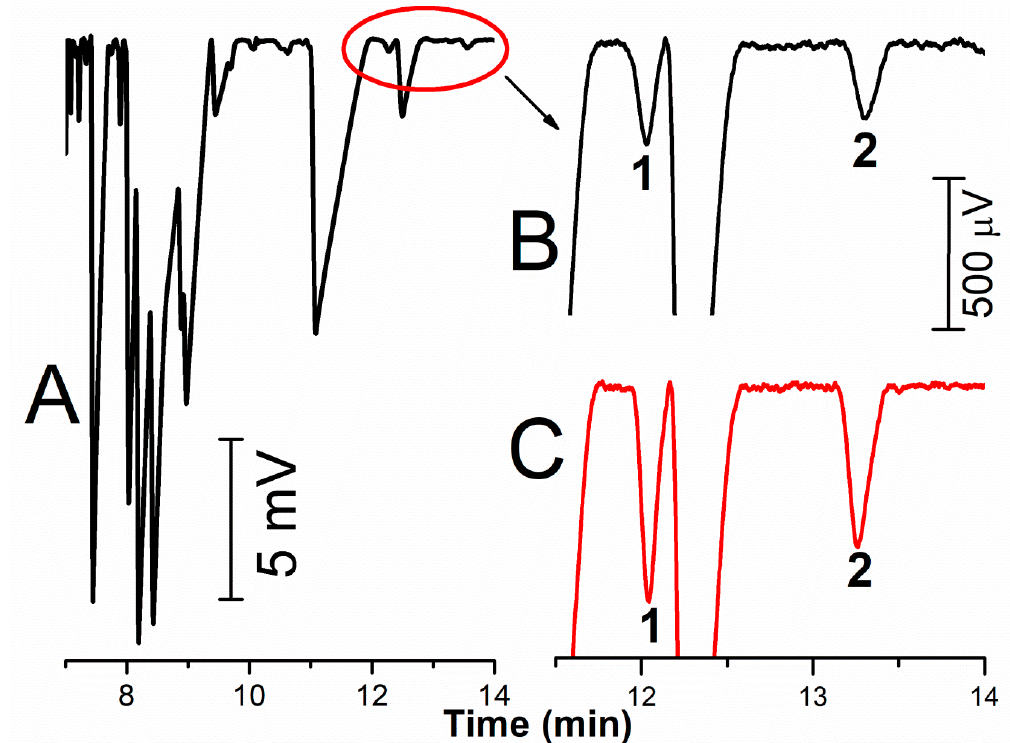
Figure 3. CE/C 4 D separation of human plasma treated by ACN (1:3) after filling the whole capillary with the sample ( A ); ( B )—zoomed part of the electropherogram with the peaks of ADMA (1) and SDMA (2); ( C )—the same plasma after the addition of 0.2 µM ADMA and SDMA.